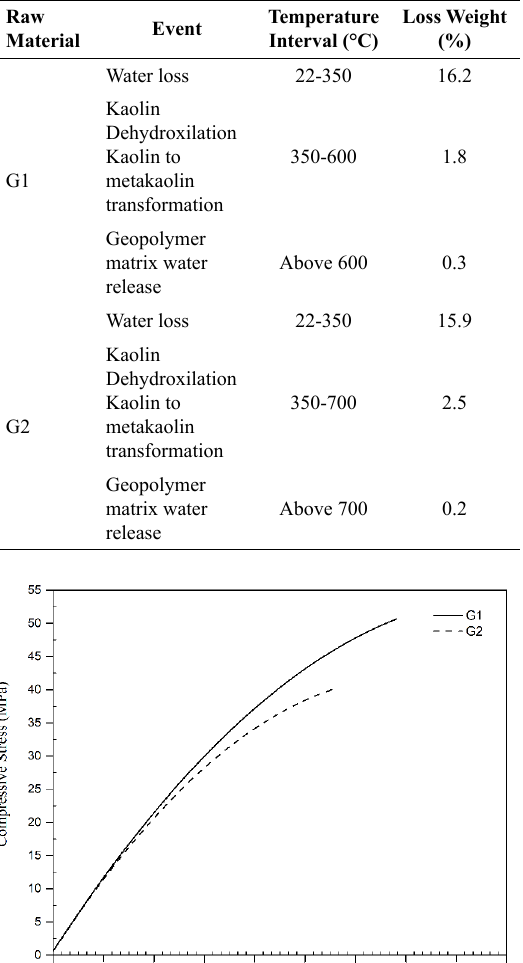
Table 8. Mass loss intervals for geopolymers (G1 and G2).